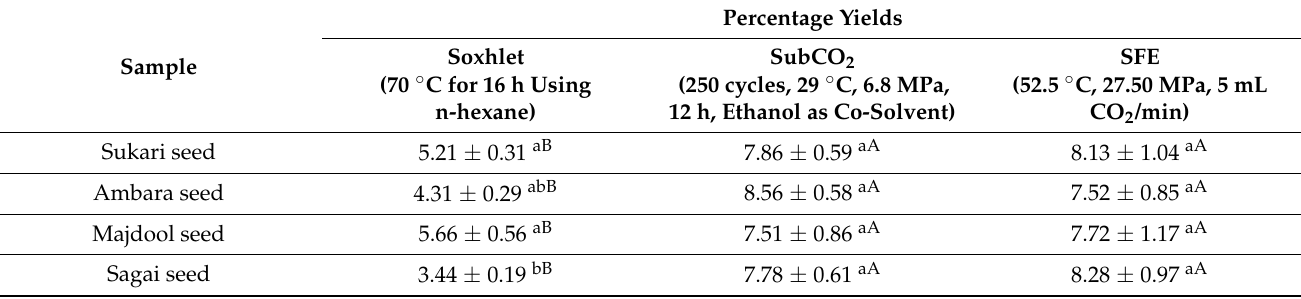
Table 2. The percentage yields of date seed samples using Soxhlet and Subcritical CO 2 (SubCO 2 ) and supercritical fluid (SFE) extraction